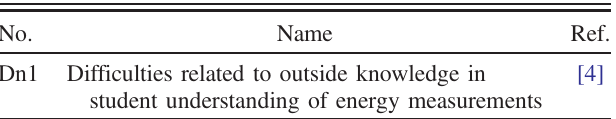
TABLE III. Difficulties that exhibit only displacement error in simpler problems which do not require frame shifting. These difficulties are labeled D for displacement errors and “ n ” because their problems require no shifting. The ordering of the difficulties in the table is for labeling purposes only and does not represent a hierarchy.